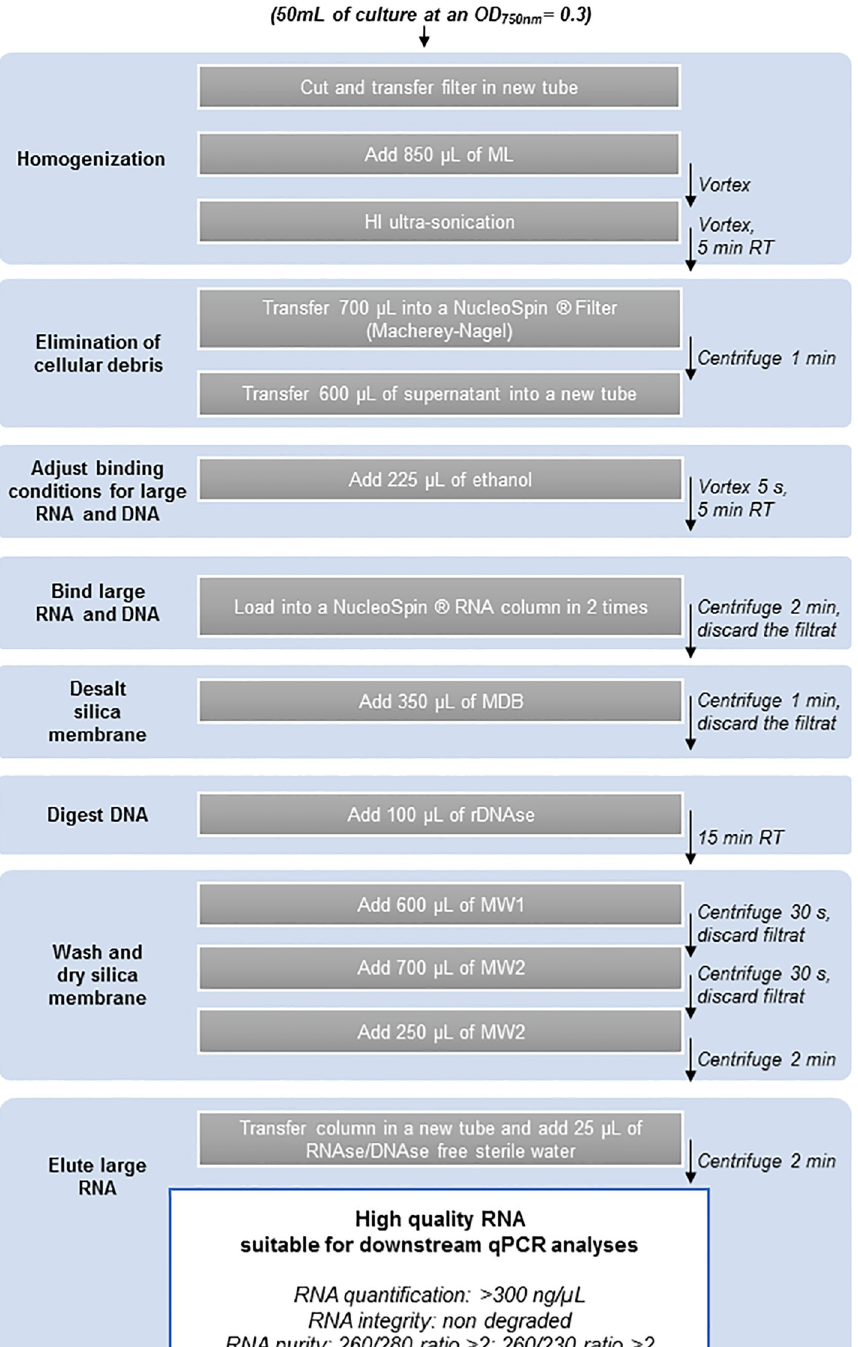
PLOS ONE | https://doi.org/10.1371/journal.pone.0222029 September 6,